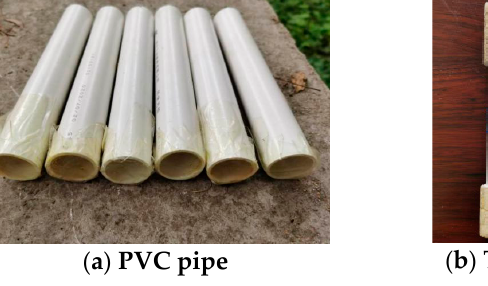
Figure 6. Tensile moulds and samples.